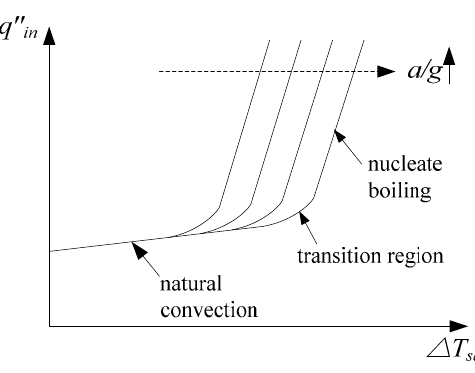
Figure 9. Relationship between heat transfer mechanisms and acceleration [22].